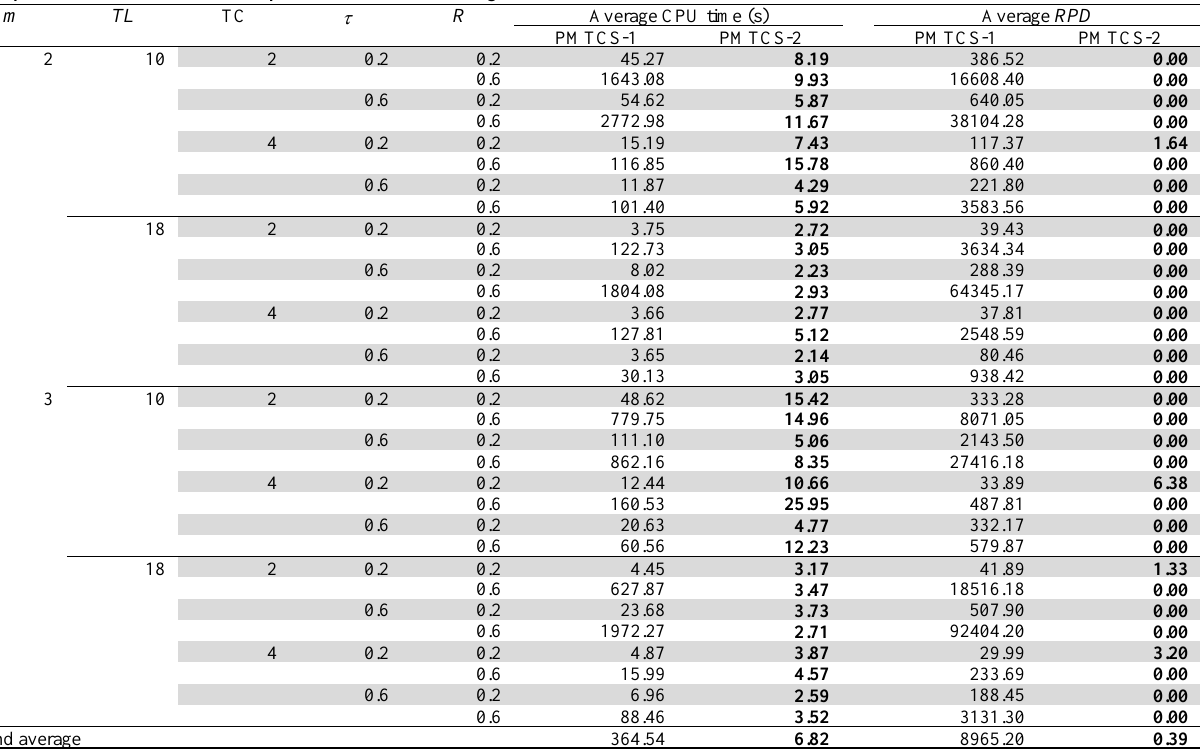
Computational results for problems with 12 jobs